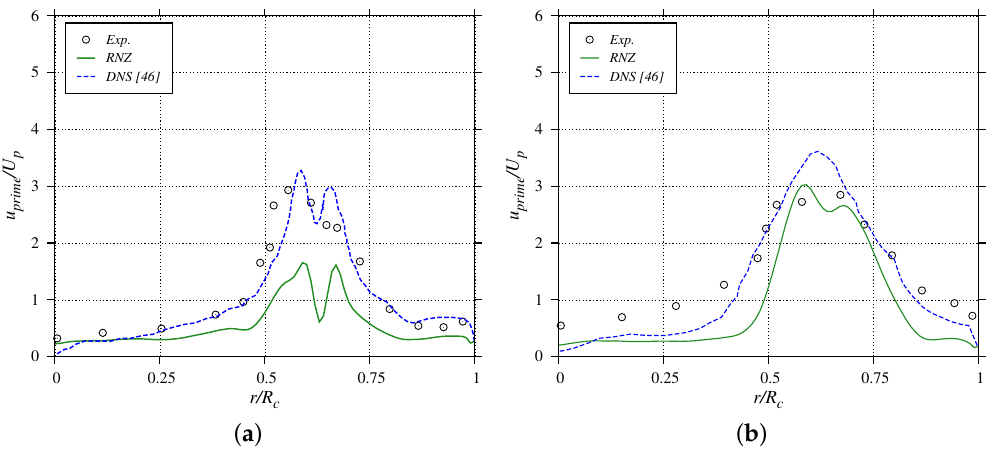
Figure 11. Radial distribution of the RMS axial velocity fluctuation u prime at θ = 36 ◦ : ( a ) z = − 10 mm; ( b ) z = − 20 mm.